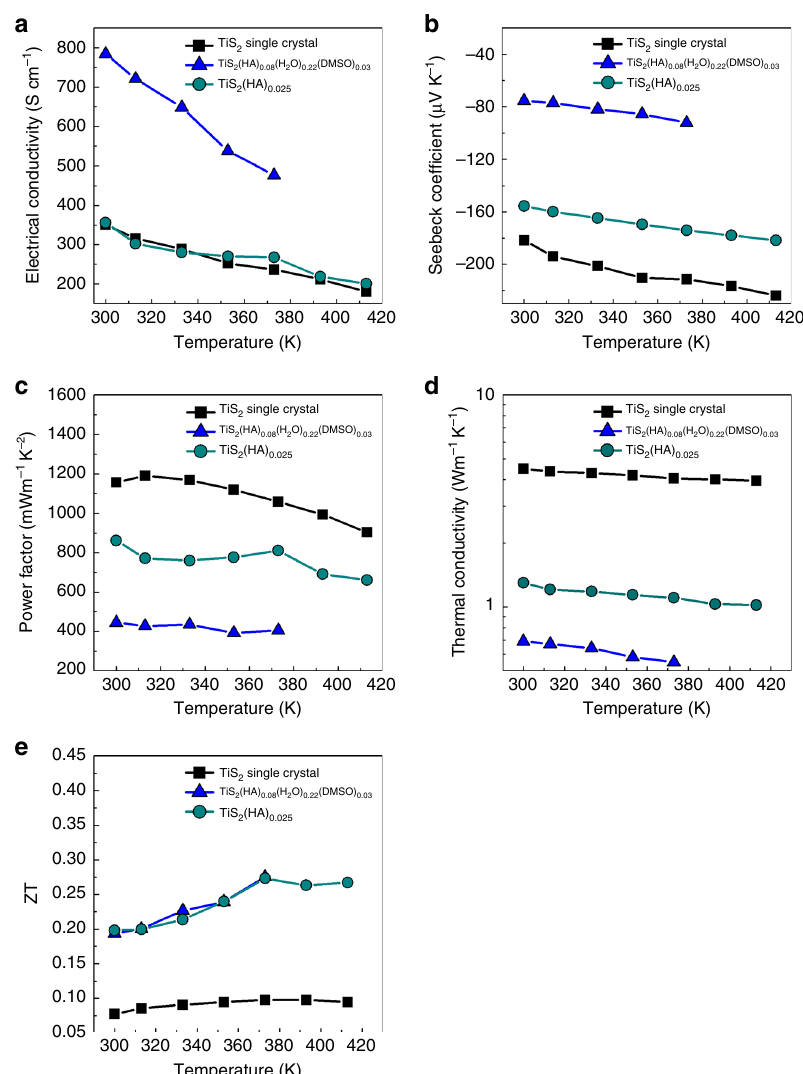
Fig. 2 In-plane thermoelectric properties of TiS 2 (HA) 0.25 compared with TiS 2 single crystal and TiS 2 (HA) 0.08 (H 2 O) 0.22 (DMSO) 0.03 : a in-plane electrical conductivity, b in-plane Seebeck coef fi cient, c in-plane power factor, d in-plane thermal conductivity, e in-plane thermoelectric fi gure of merit, ZT